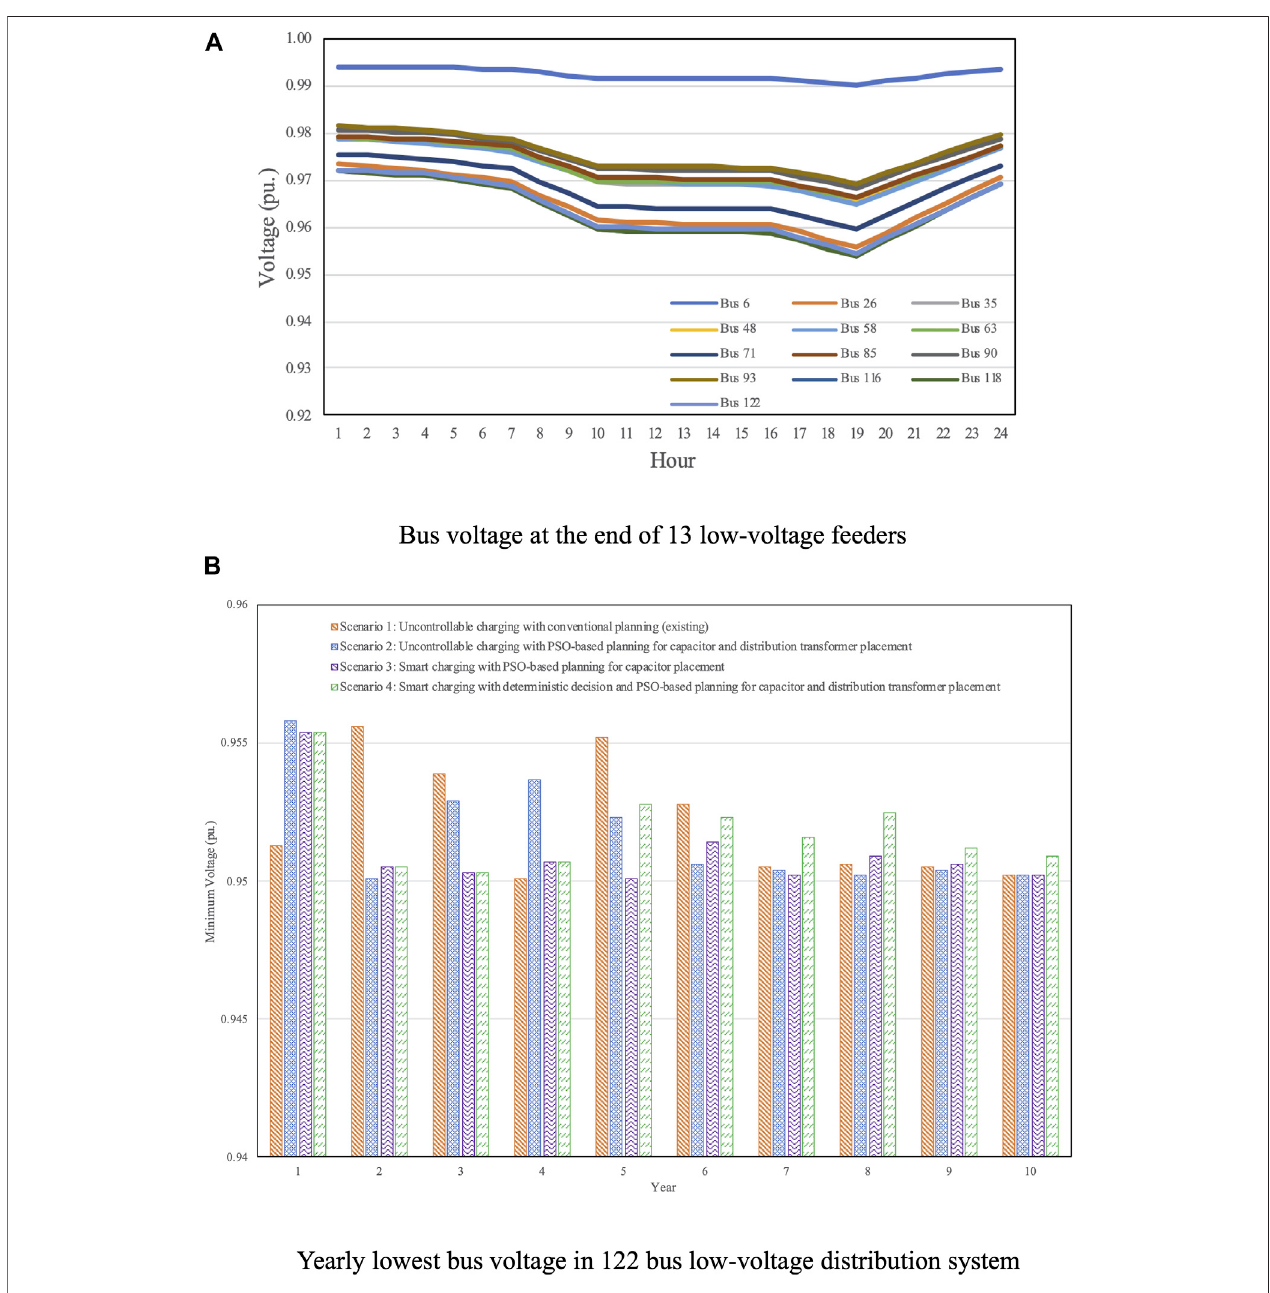
FIGURE 9 | Bus voltage in 122 bus LV distribution